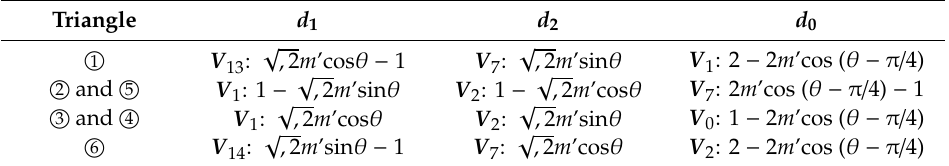
Table 6. Duty cycles of basic voltage vectors used to synthesize the reference voltage